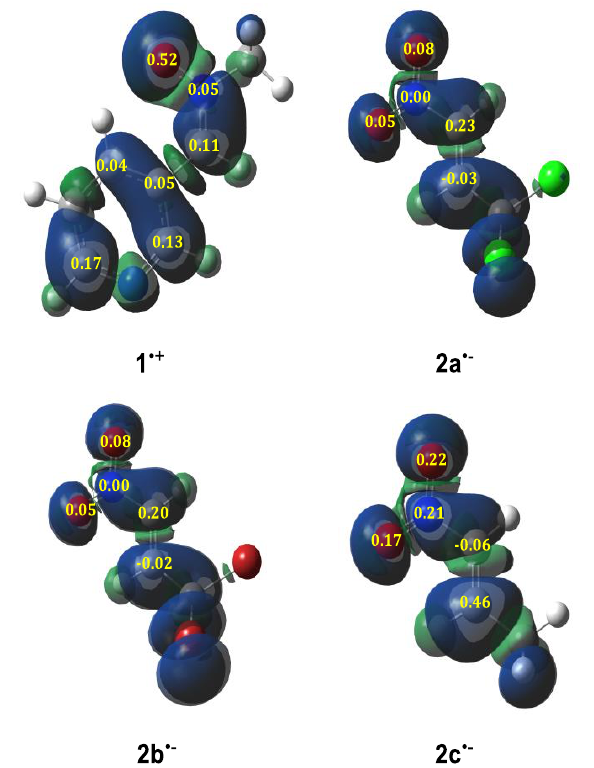
Figure 2. The Mulliken atomic spin densities (ASD) 3D representations of the radical cation of the nitrone 1, and the radical anions of the 1-nitropropenes 2a–c, and the corresponding nucleophilic and electrophilic Parr functions.